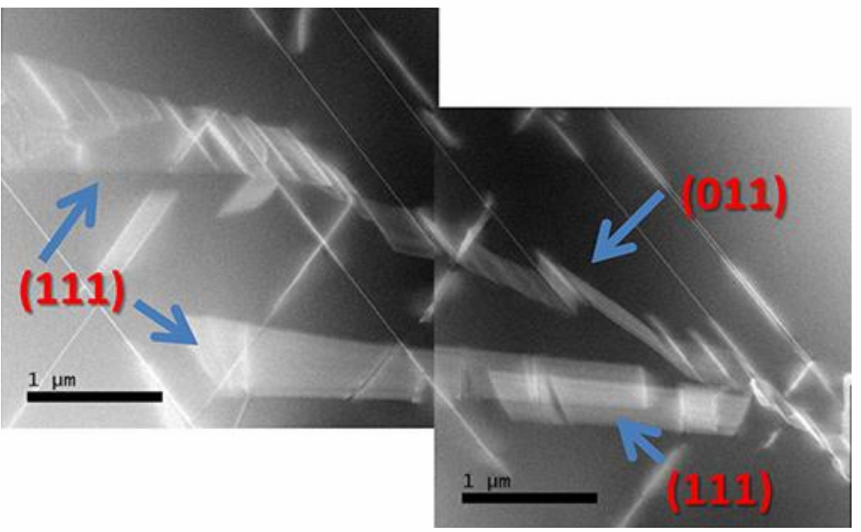
Figure 13. Sequence of STEM (110) cross-view images showing an IDB and its interaction with SFs. The lying planes of IDB and SFs are indicated (adapted from Reference